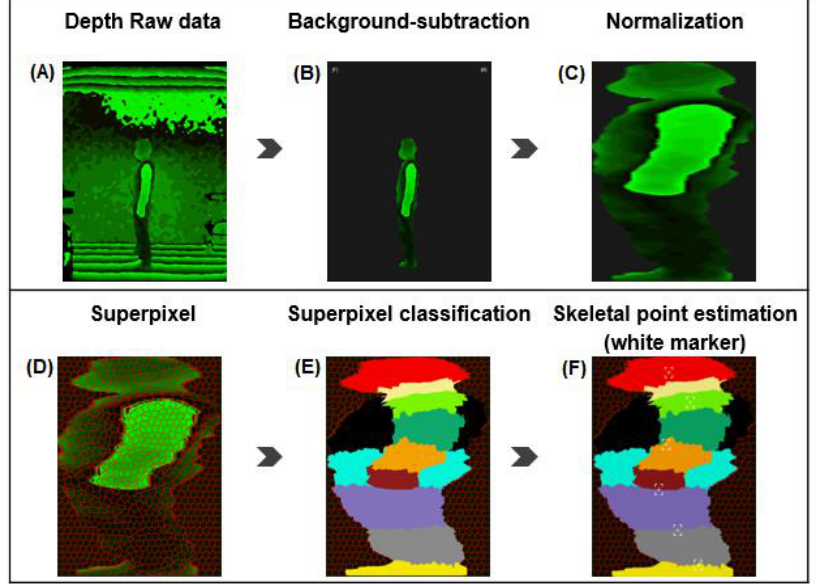
Figure 1. An example of the measurement in the side ( A ). The flow of the human skeletal pose estimation method from the depth camera. After producing a human silhouette using the background-subtraction method ( B ), the human finally becomes normalized ( C ). The classification of body parts with various colors shows an already trained processing algorithm for segmentation via Simple Linear Iterative Clustering ( D , E ). Results of the skeletal point estimation on a human body are extracted by using an image processing algorithm. In a markerless object ( E ), white markers are created via a series of processes ( F ). Illustration provided by MG solutions.